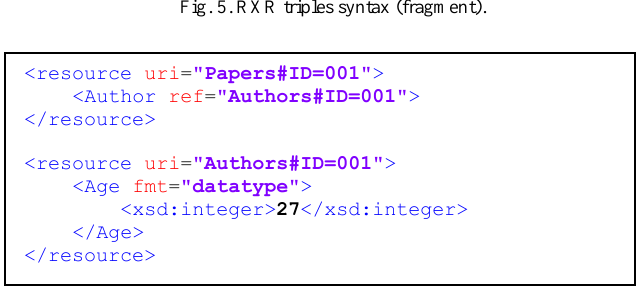
Fig. 6. Grit triples syntax (fragment).